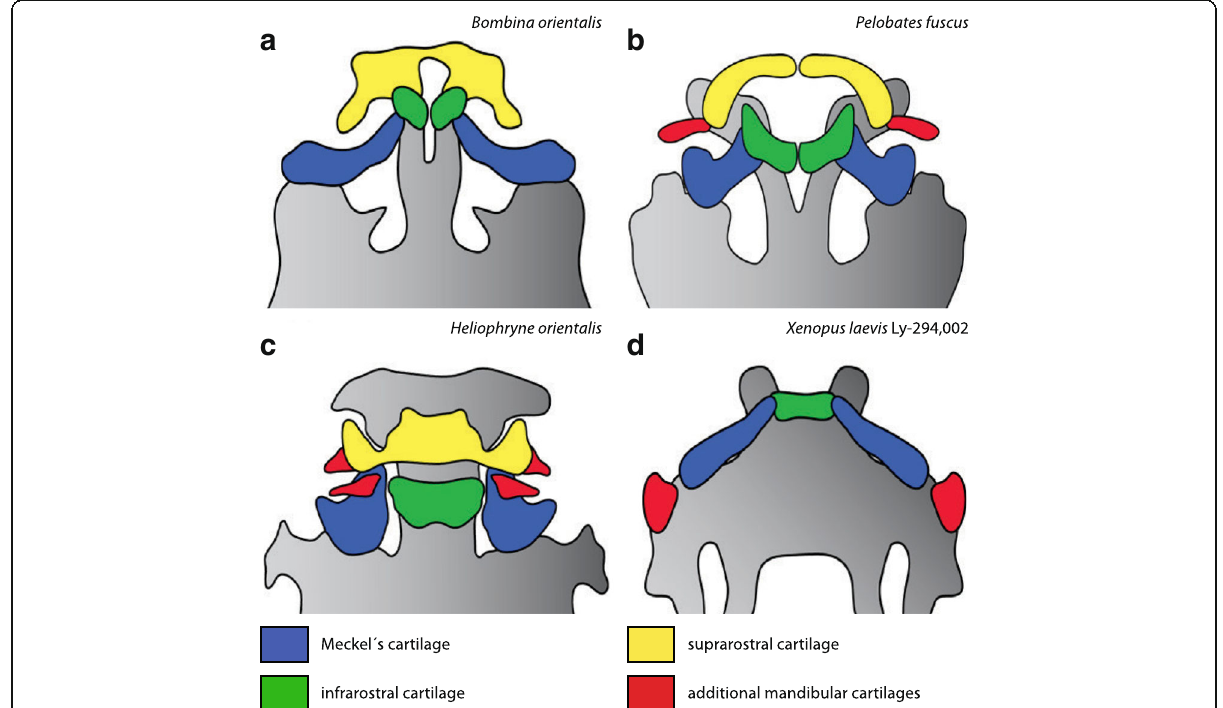
Fig. 8 Overview of the diversity of adrostral cartilages among anurans. Ventral view of the jaw region of selected anuran larvae. a Bombina orientalis shows a typical anuran condition of the jaw region consisting of paired infrarostral cartilages, a plate-like suprarostral cartilage and horizontally oriented Meckel ’ s cartilages. b In Pelobates fuscus (drawn after Nikitin 1986) two so-called adrostral cartilages can be observed lateral to the paired suprarostral cartilages. c Heliophryne orientalis possesses two additional cartilages in the lower jaw. The submeckelian cartilages lie beneath Meckel ’ s cartilages and the adrostral cartilages are situated lateral to the suprarostral cartilage. In Ly-294,002-treated Xenopus laevis larvae ( d ) the ectopic cartilages arise lateral to the palatoquadrate and are free from any muscle insertion or origination similar to P. fuscus and H.